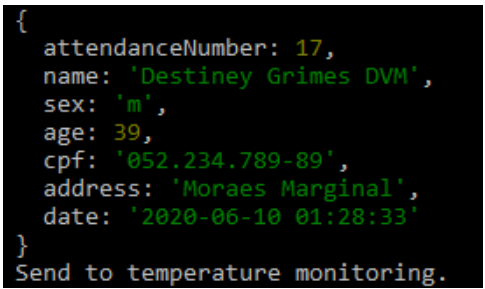
Figure 11. Saved